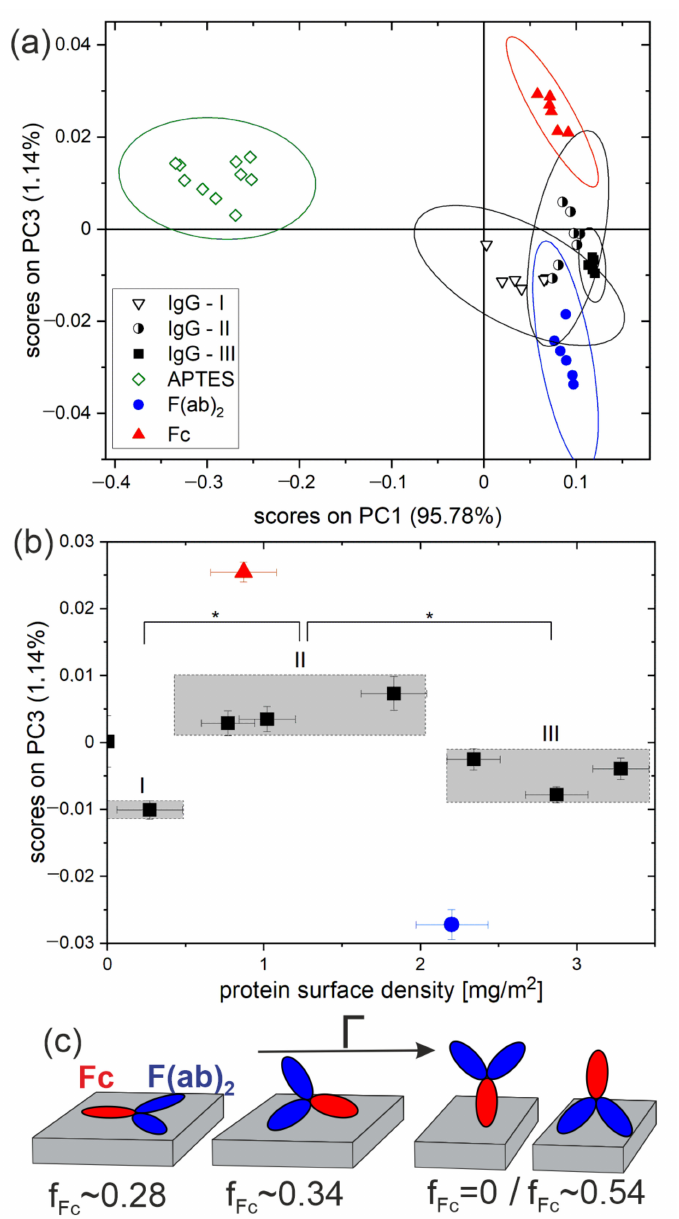
Figure 4. TOF-SIMS and PCA analysis of the surface density-dependent orientation of IgG molecules on APTES-modified silicon substrates. ( a ) PC1 vs. PC3 scores plot for a developed PCA model involving bare substrate, representative immobilized IgG layers with surface densities corresponding to different orientations (I—flat-on, II—side-on and III—vertical orientation), as well as reference surfaces with immobilized antibody fragments F(ab) 2 and Fc. The ellipses around each of the grouped data points represent the 95% confidence limit. ( b ) Mean values of the scores on PC3 versus the surface density Γ of IgG molecules. Three data points groups corresponding to different IgG orientations (in sequence flat-on, side-on, and tail-on/head-on) can be distinguished (* significantly different from each other, p < 0.05). Error bars are standard deviations determined from 6 to 10 TOF-SIMS measurements and 5 ellipsometry measurements of the same sample. ( c ) Scheme of subsequent orientations of immobilized IgG molecules, adapted with increasing protein surface density Γ , with the corresponding values of the areal fraction of the exposed Fc domain ( f Fc ) deduced from MD simulations by Vilhena et al.